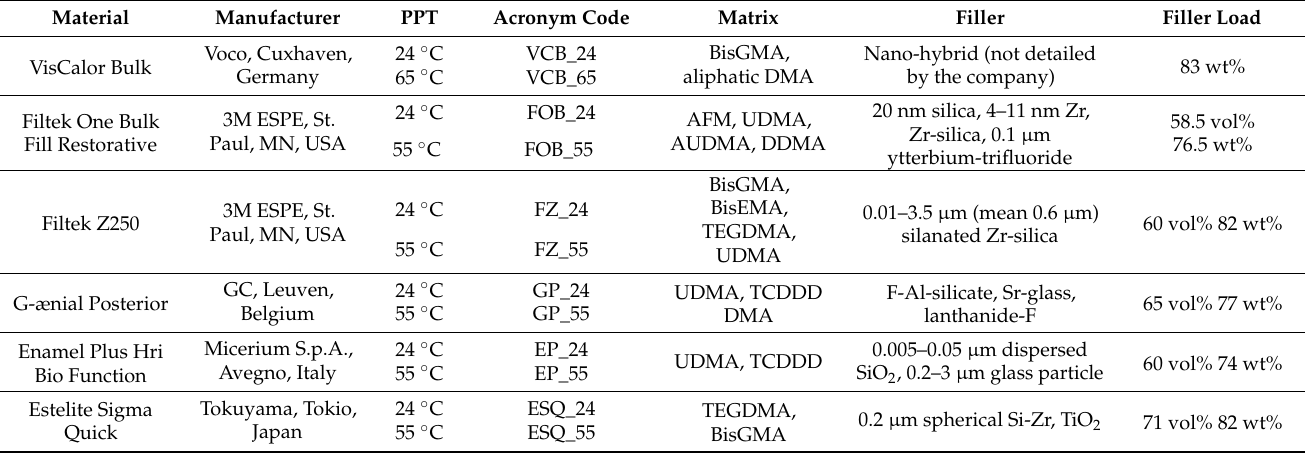
Table 3. Composition, manufacturers, codes, and pre-polymerization temperature of the investigated resin-based